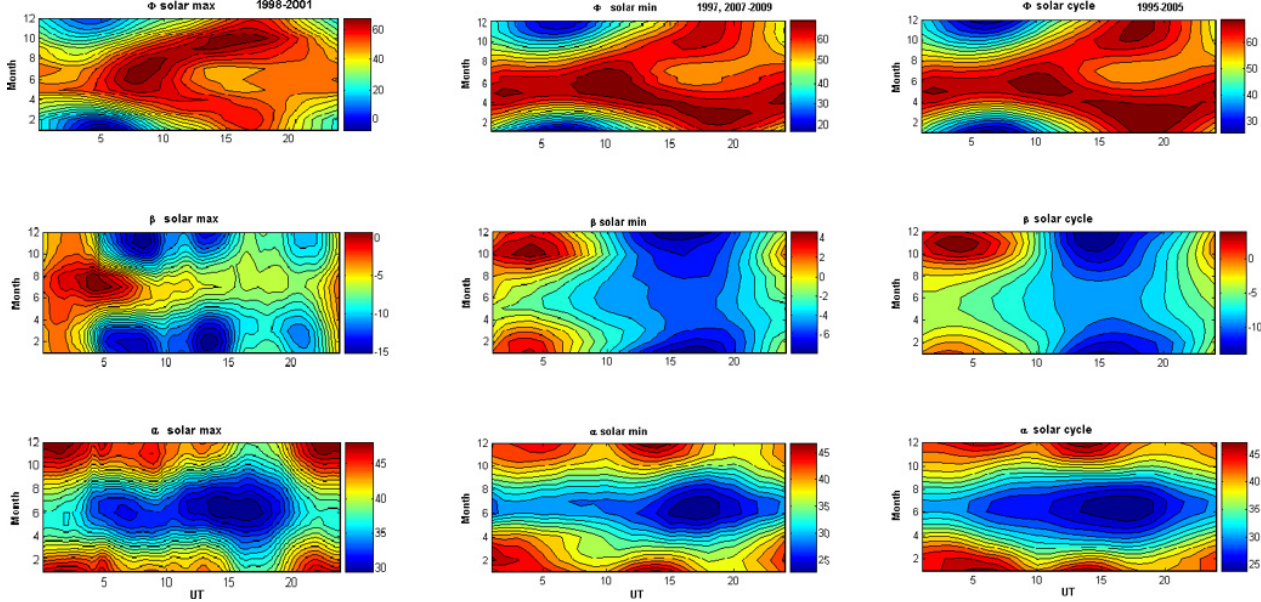
Fig. 5. Parameters φ , β , and α derived for Vostok station independently for epoch of solar maximum (1998–2001) [Troshichev et al., 2006], for epoch of solar minimum (1997, 2007–2008), and for complete cycle of solar activity (1995–2005) (AARI#3 version); the axis of abscises being for UT and axis of ordinates being for